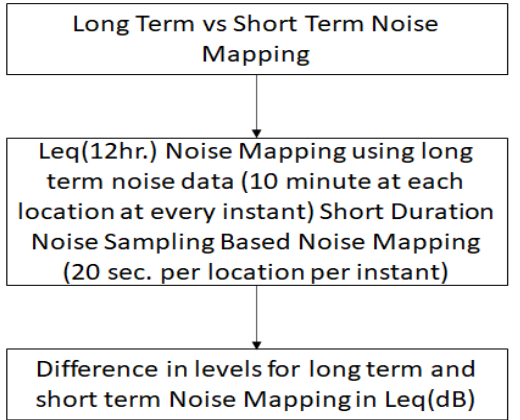
Figure 7. Difference in Predicted Noise Levels Maps for noisy Bahadurpur Intersec ‐ tion .